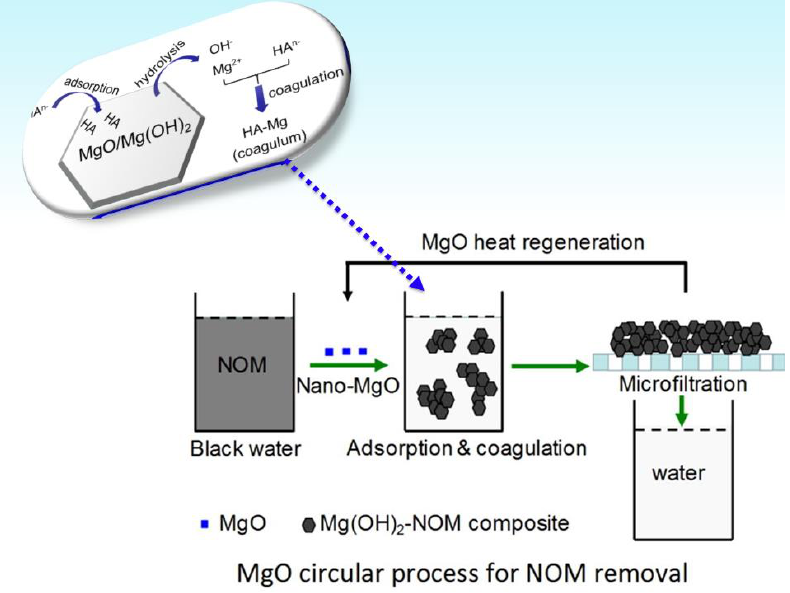
Figure 7. Representation of the natural organic matter removal approach by recycling MgO. Adapted from Zhou et al. [84].